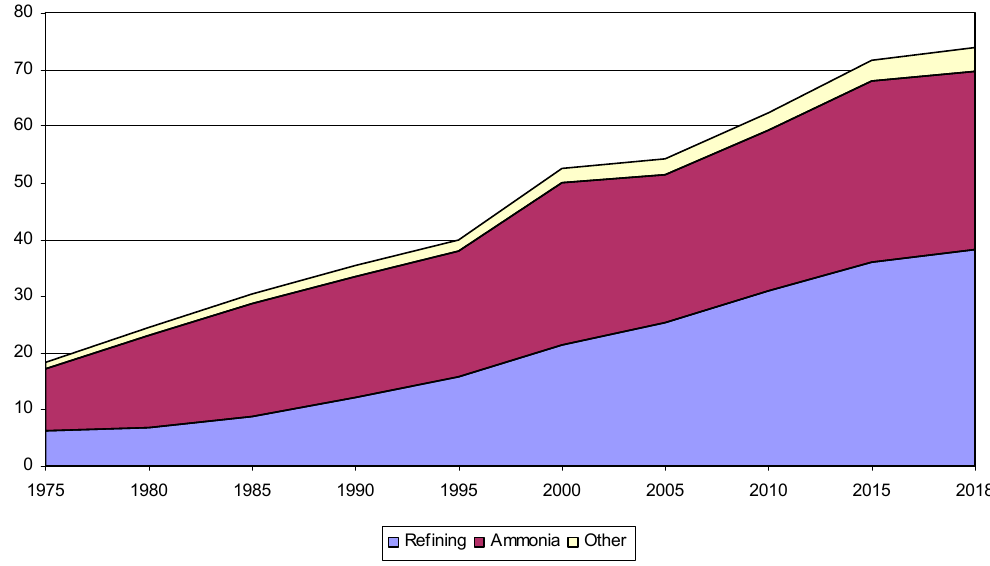
Figure 1. Global demand for pure hydrogen, 1975–2018. Source: https://www.iea.org [3]. The preliminary analysis allows identifying at least four areas that demonstrate the greatest potential for the use of hydrogen, and where it can contribute to the successful decarbonization and global energy transformation in Europe: power and heat production, transport, and industry (Figure 2).